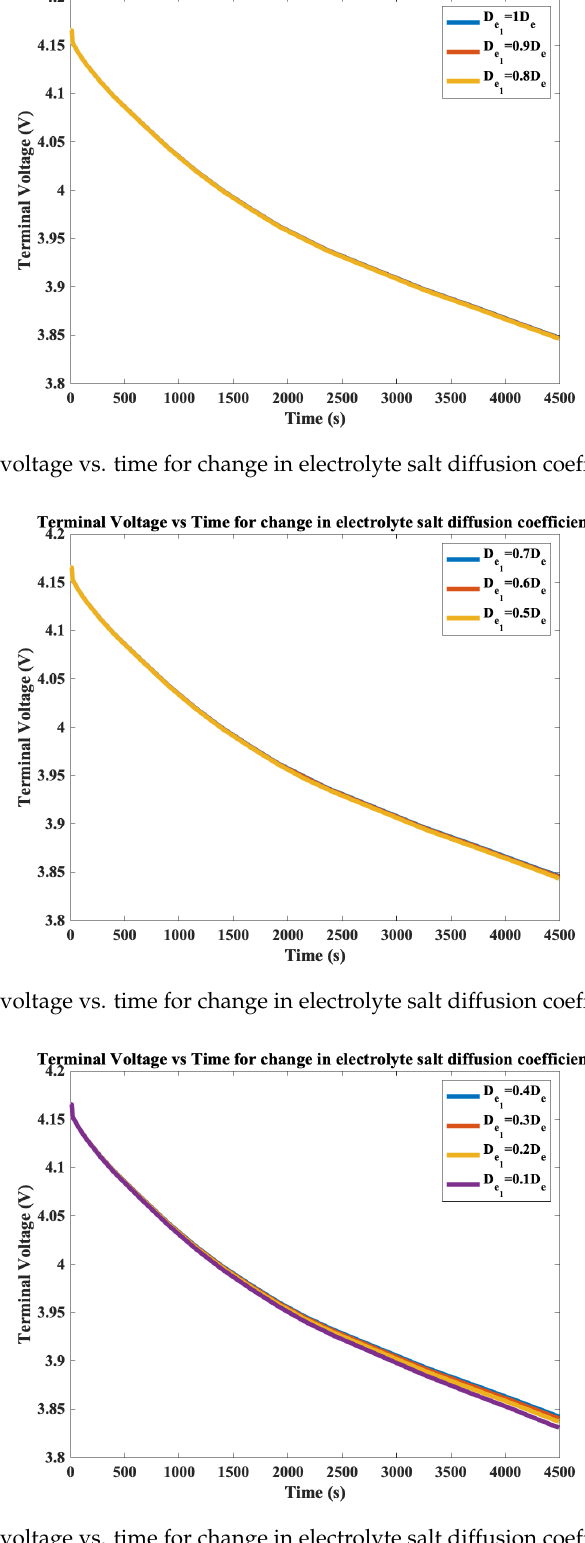
Figure 5. Terminal voltage vs. time for change in electrolyte salt diffusion coefficient from 0.4 to